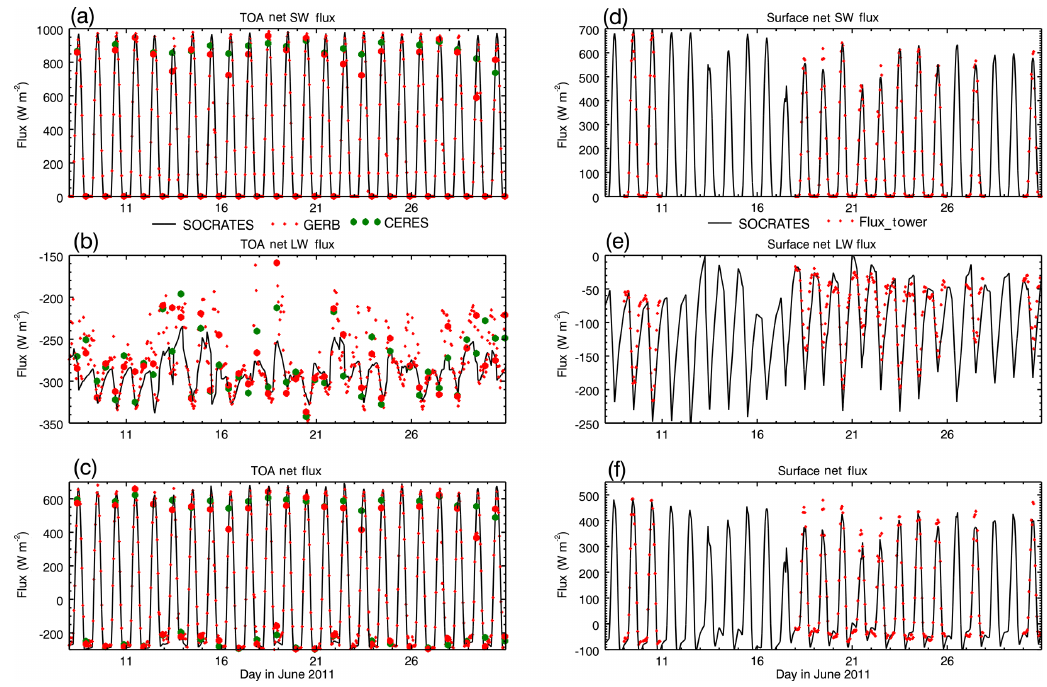
Figure 9. Time series of radiative flux at BBM. TOA longwave (a) , shortwave (b) , and net (c) . Surface shortwave (d) , longwave (e) , and net (f) . The bigger red dots denote GERB measurements corresponding to CERES time steps.